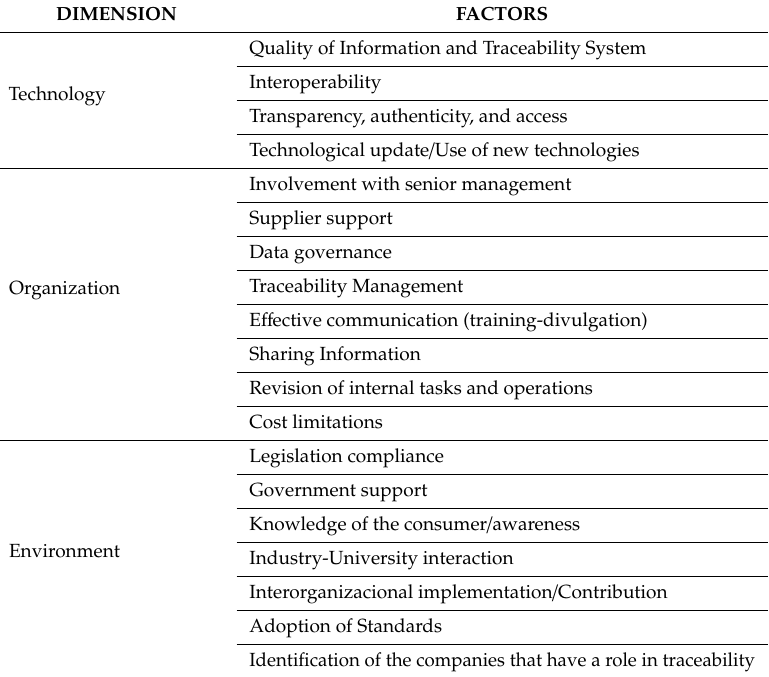
Table 7. CSFs for the implementation of a drug traceability